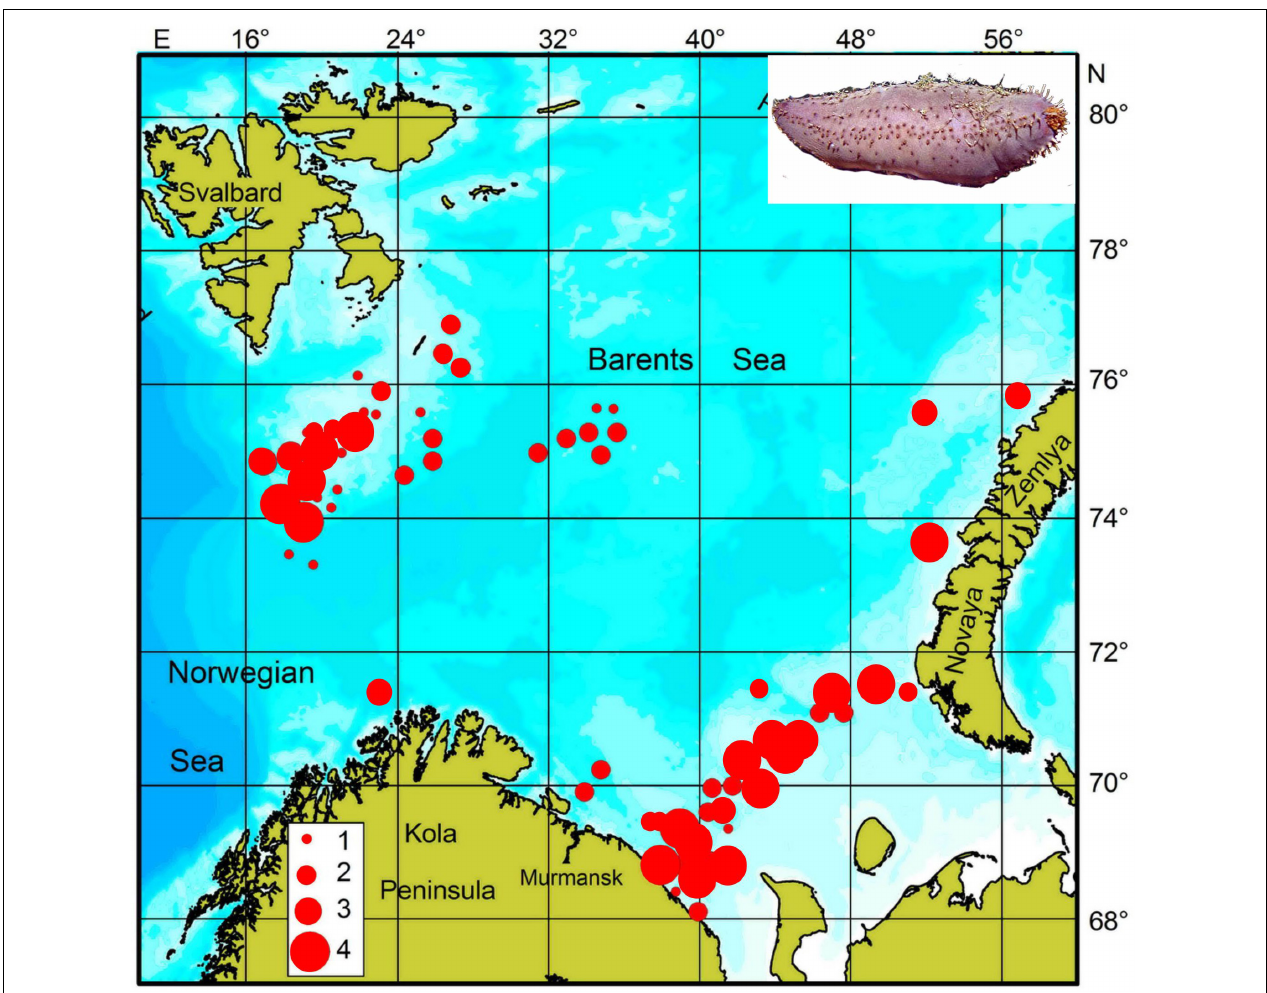
FIGURE 1 | Distribution of Cucumaria frondosa in the central part (Spitsbergen Bank) and in the south-eastern part of the Barents Sea (integrated data from scientific trawl surveys conducted in the 1980–1990s and 2005–2015). 1 – < 10 g · m − 2 , 2 – 10–30 g · m − 2 , 3 – 30–70 g · m − 2 , 4 – > 70 g · m − 2 (adopted from Gudimova, 1998a; Zakharov et al.,